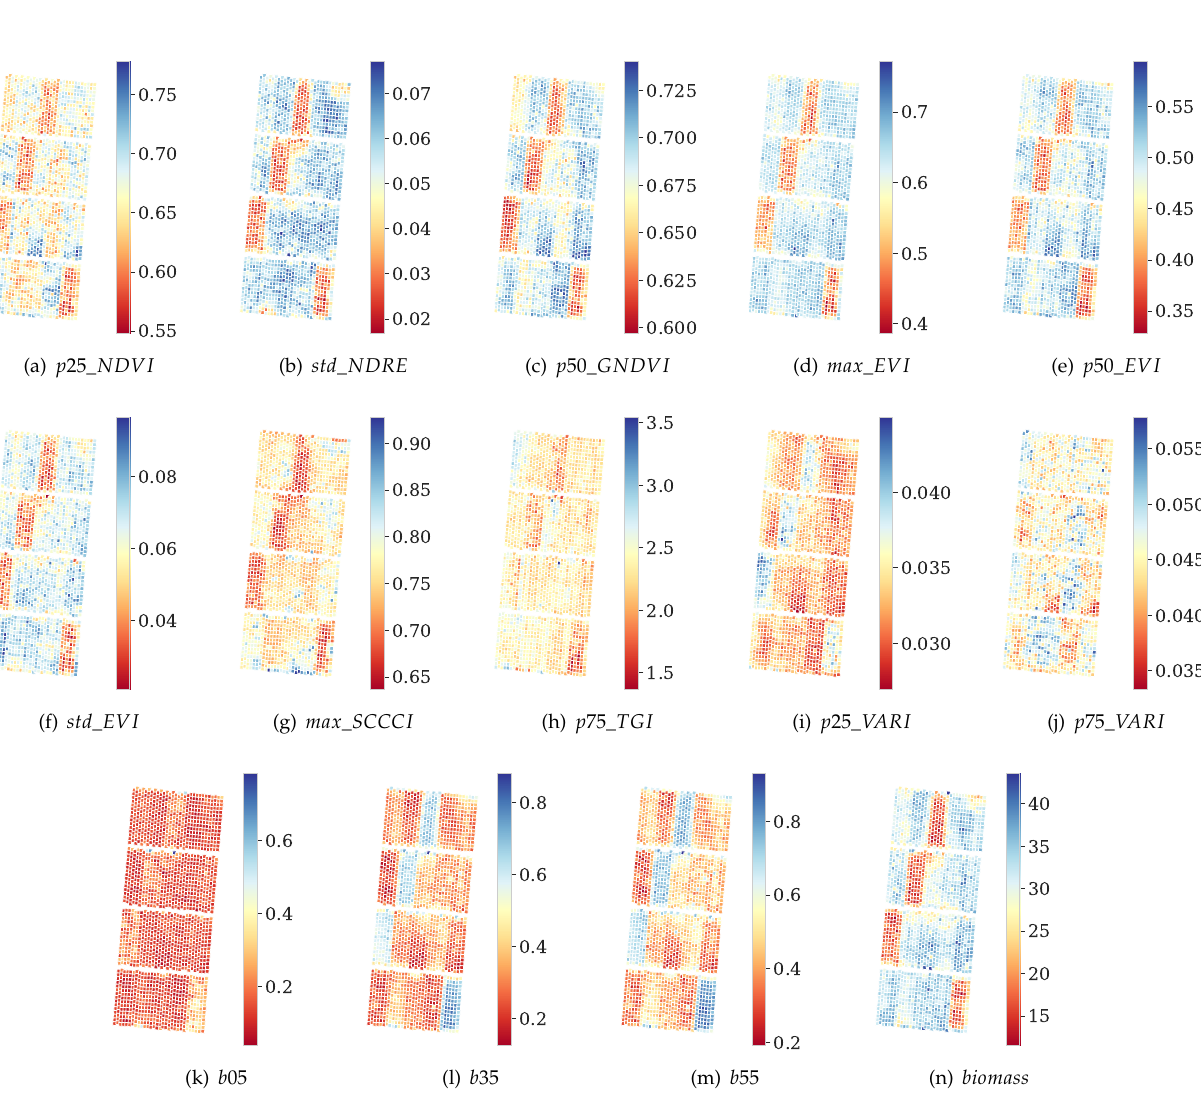
Figure 6. Visualization of the growth status of the whole planted area with respect to each selected key metric. The final biomass map shows that most of the selected key indicators are correlated with crop